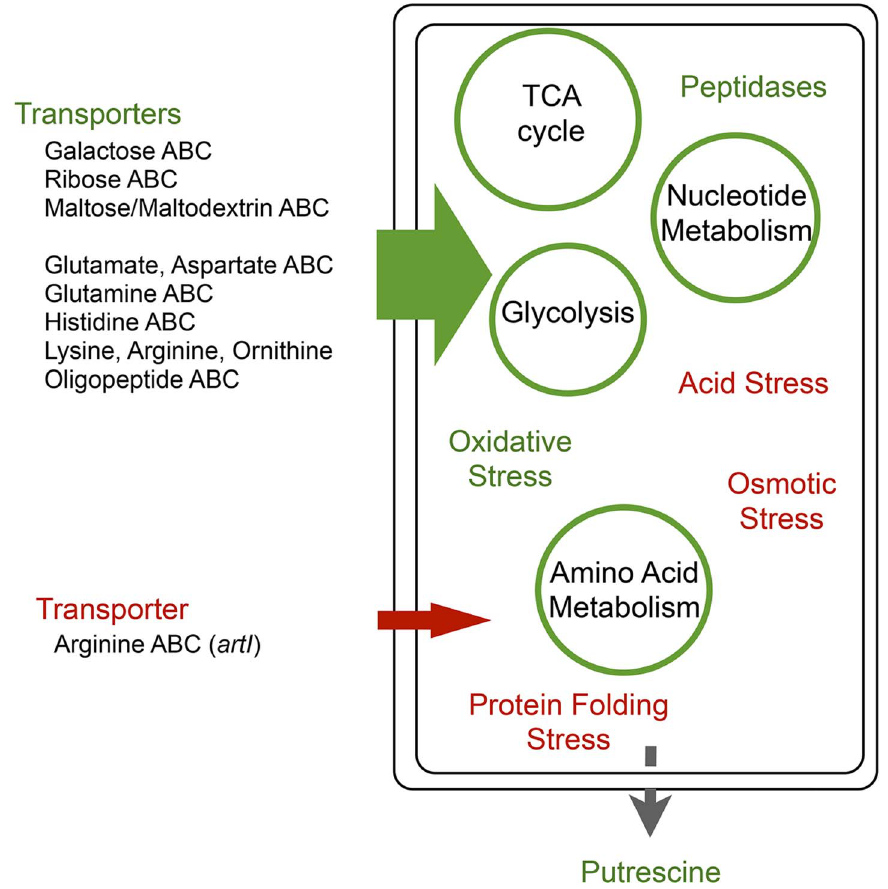
Fig. 9. Global regulators arcA and rpoS provide a comprehensive metabolic shift during adaptation that circumvents epistatic bottlenecks. Adaptation to the amino acid rich conditions of BHI by E.coli are consistent with a ‘metabolic selection’ that provides a facile strategy for shifting environments. Up-regulated systems (green) are associated with the movement of abundant amino acids into the cell coupled with an increased capacity for catabolic metabolism through the TCA cycle with excess nitrogen being secreted as putrescine. Down-regulated systems (red) include components of the starvation stress response consistent with the maintenance of a new nutrient rich homeostasis.